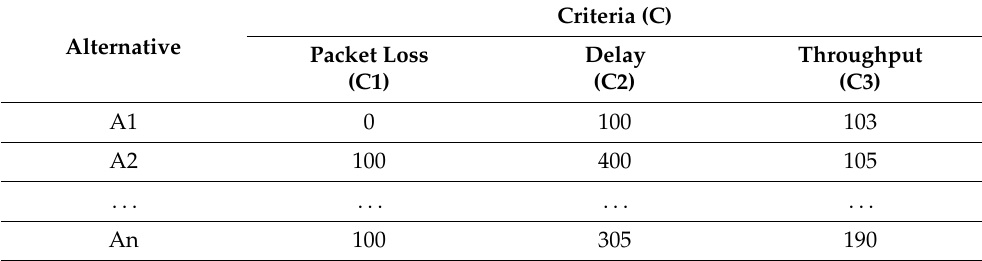
Table 7. Alternatives with criteria.